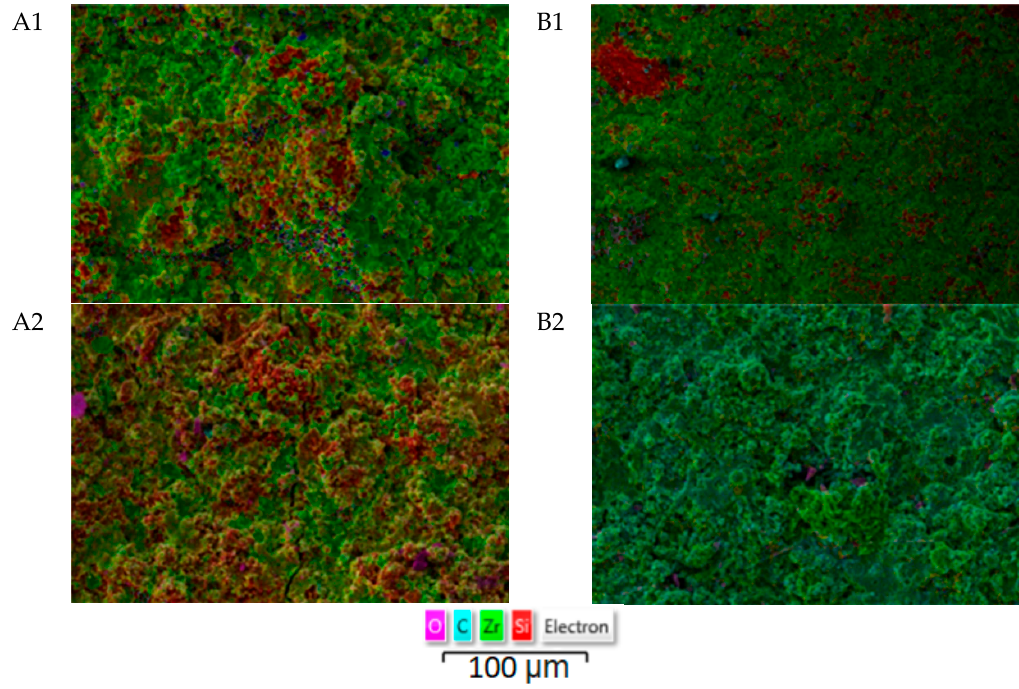
Figure 7. EDS of SiC-ZrB 2 for A1, B1, A2 and B2 coatings. For all samples in Figure 8, the thermal diffusiveness versus temperature, curves are shown. The diffusiveness of both the SiC-ZrB 2 mixtures increases with a greater content of SiC and reduces the layer thickness of the deposited coating, with room temperature values ranging from 21.0 cm 2 /s for the B2 layer to 27.5 cm 2 /s for the B1 layer. In addition, the coating/substrate matching of the A1 and A2 layers suggests slightly but consistently lower diffusivity values at high temperatures. Figure 8. Diffusivity as a function of temperature for A1, B1, A2, and B2.